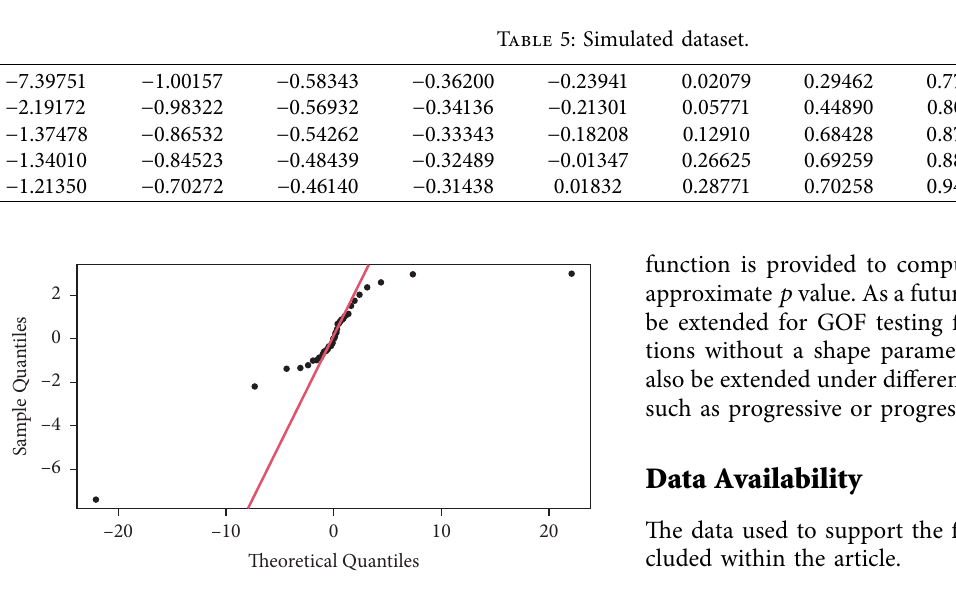
Figure 6: Cauchy Q-Q plot of simulated data.